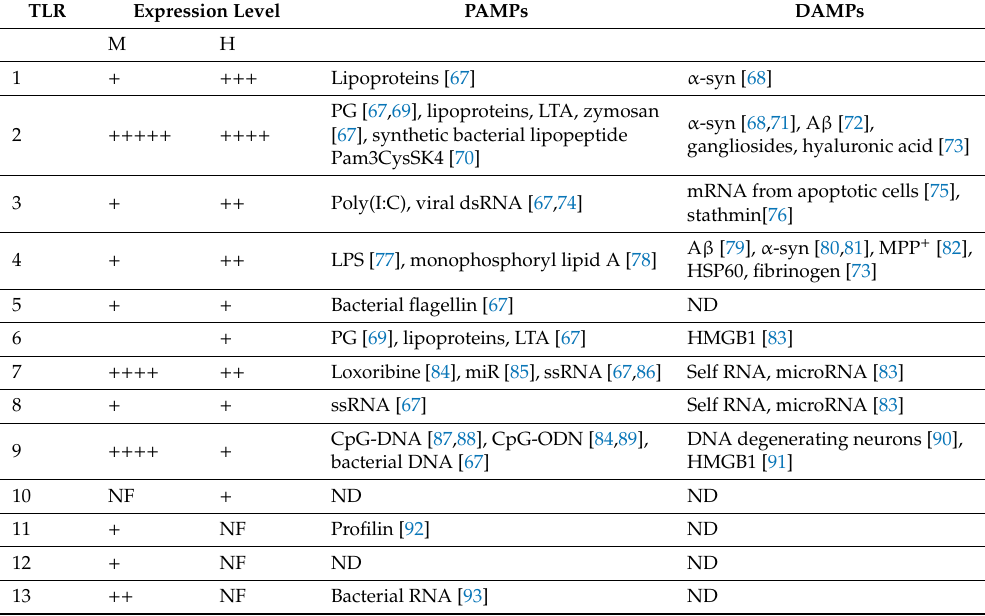
Table 1. TLRs expressed in microglia (human (H) and mouse (M)) and ligands / agonists classified in PAMPs and